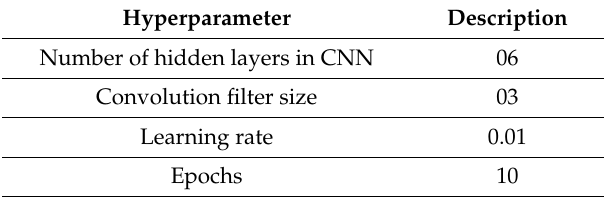
Table 2. Hyper parameters values of implemented convolutional neural network.